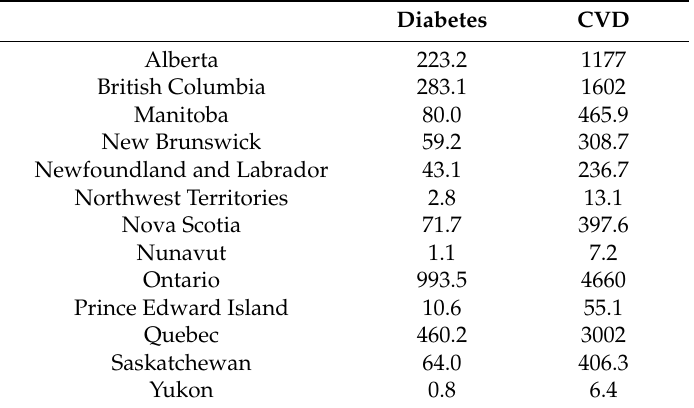
Table 3. Summary of diabetes and cardiovascular disease total cost (direct + indirect) by province/territory in Canada (Can$ million) 1 .